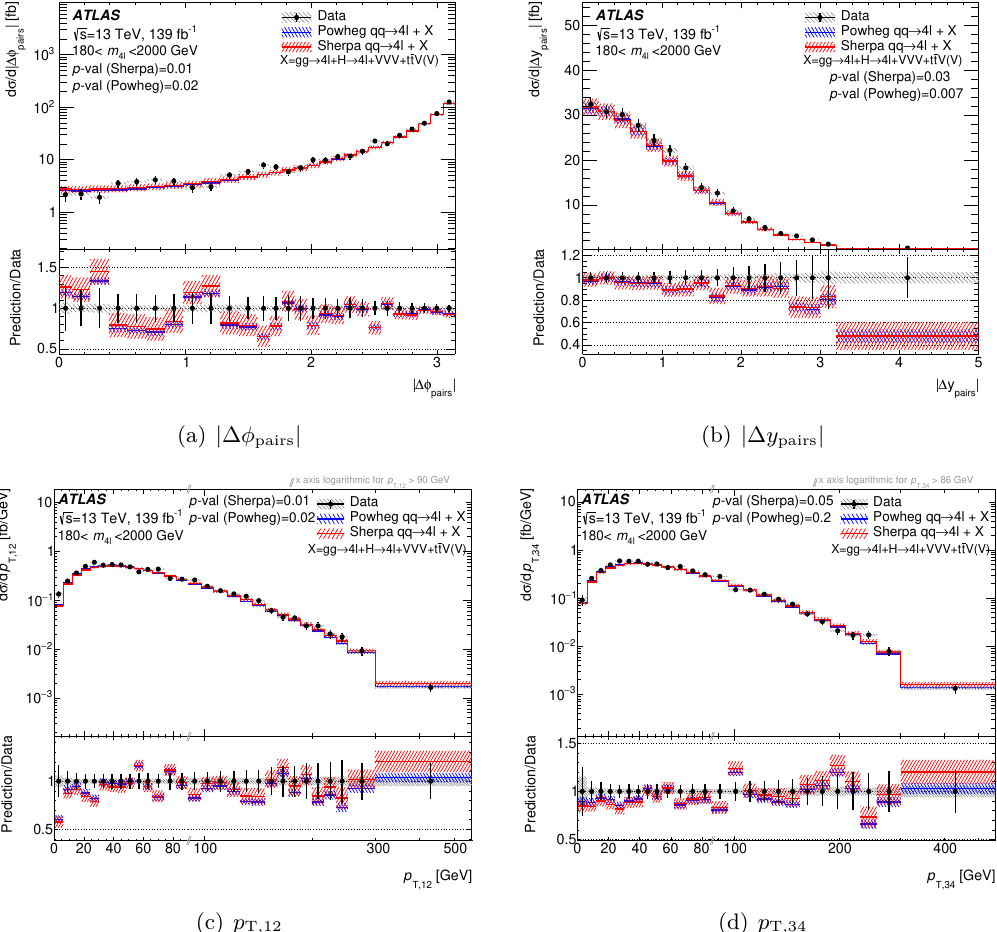
Figure 8 . Differential cross-sections as a function of (a) | ∆ φ pairs | , (b) | ∆ y pairs | , (c) p T , 12 , and (d) p in the on-shell ZZ region. The measured data (black points) are compared with the SM T , 34 prediction using either Sherpa (red, with red hashed band for the uncertainty) or Powheg + Pythia8 (blue, with blue hashed band for the uncertainty) to model the q ¯ q → 4 ‘ contribution. The error bars on the data points give the total uncertainty and the grey hashed band gives the systematic uncertainty. The p -value is the probability for the χ 2 , with the number of degrees of freedom equal to the number of bins in the distribution, to have at least the observed value, given the SM prediction. The lower panel shows the ratio of the SM predictions to the data. In (c) the x -axis is on a linear scale until p T , 12 = 90 GeV, where it switches to a logarithmic scale; in (d) it switches at p = 86 T , 34